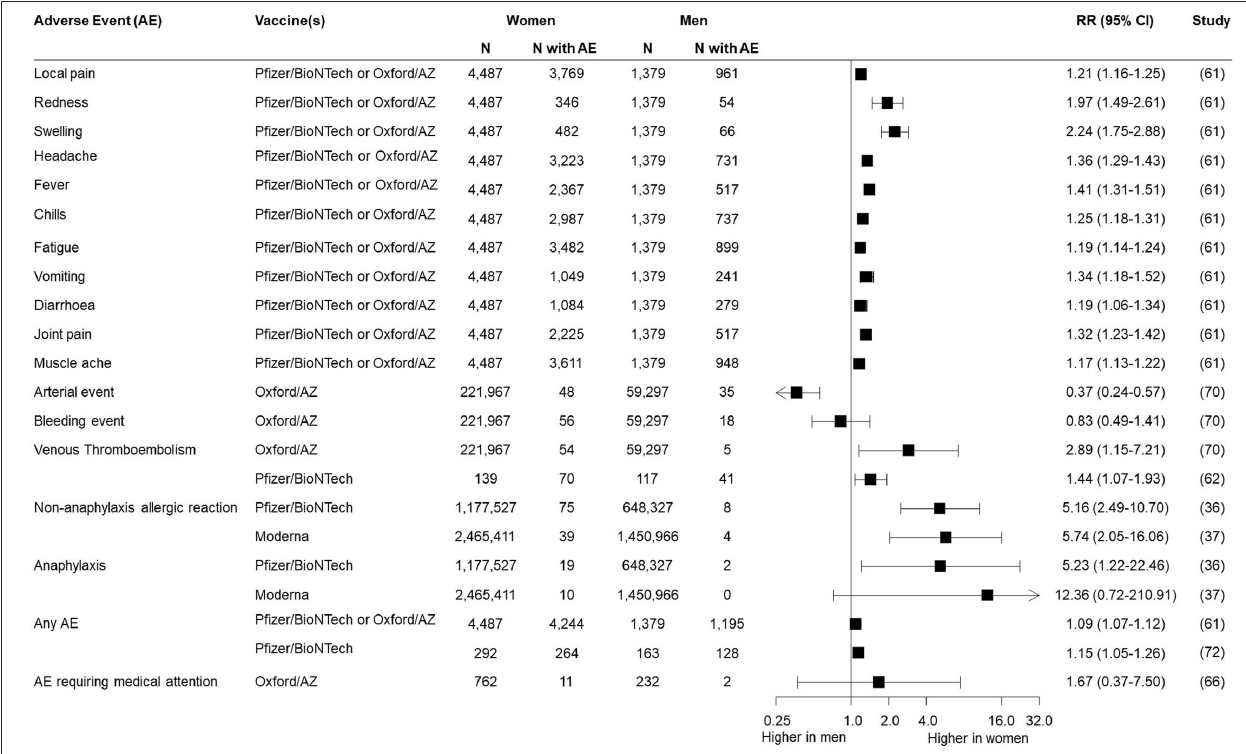
FIGURE 1 | Risk of adverse events following COVID-19 immunisation reported in women and